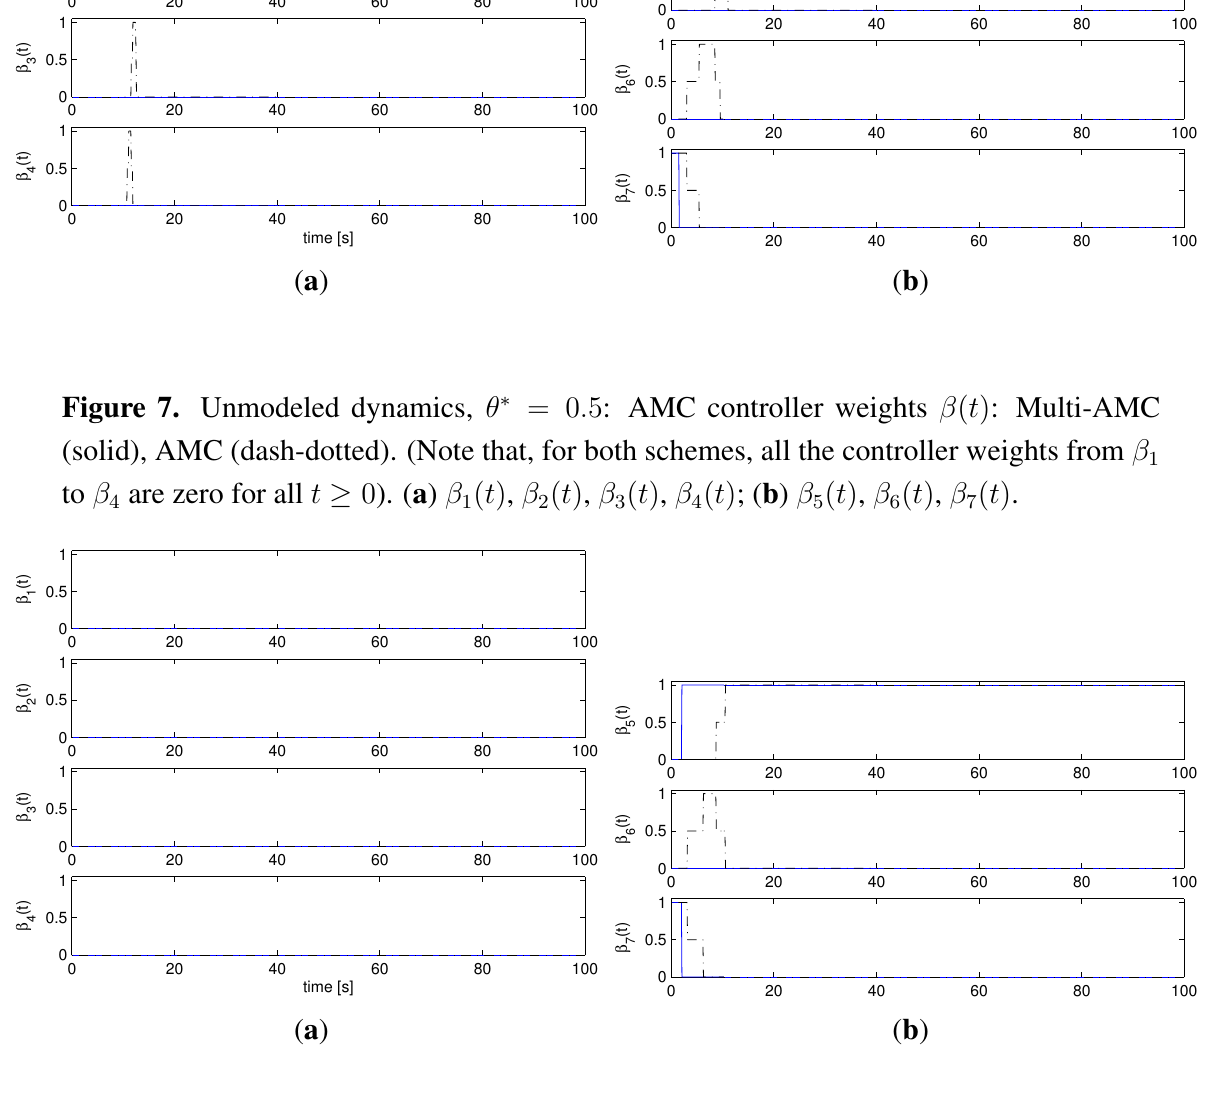
( t ) , β ( t ) , β ( t ) , β ( t ) ; ( b ) β ( t ) , β ( t ) , β ( t ) . 1 2 3 4 5 6 7